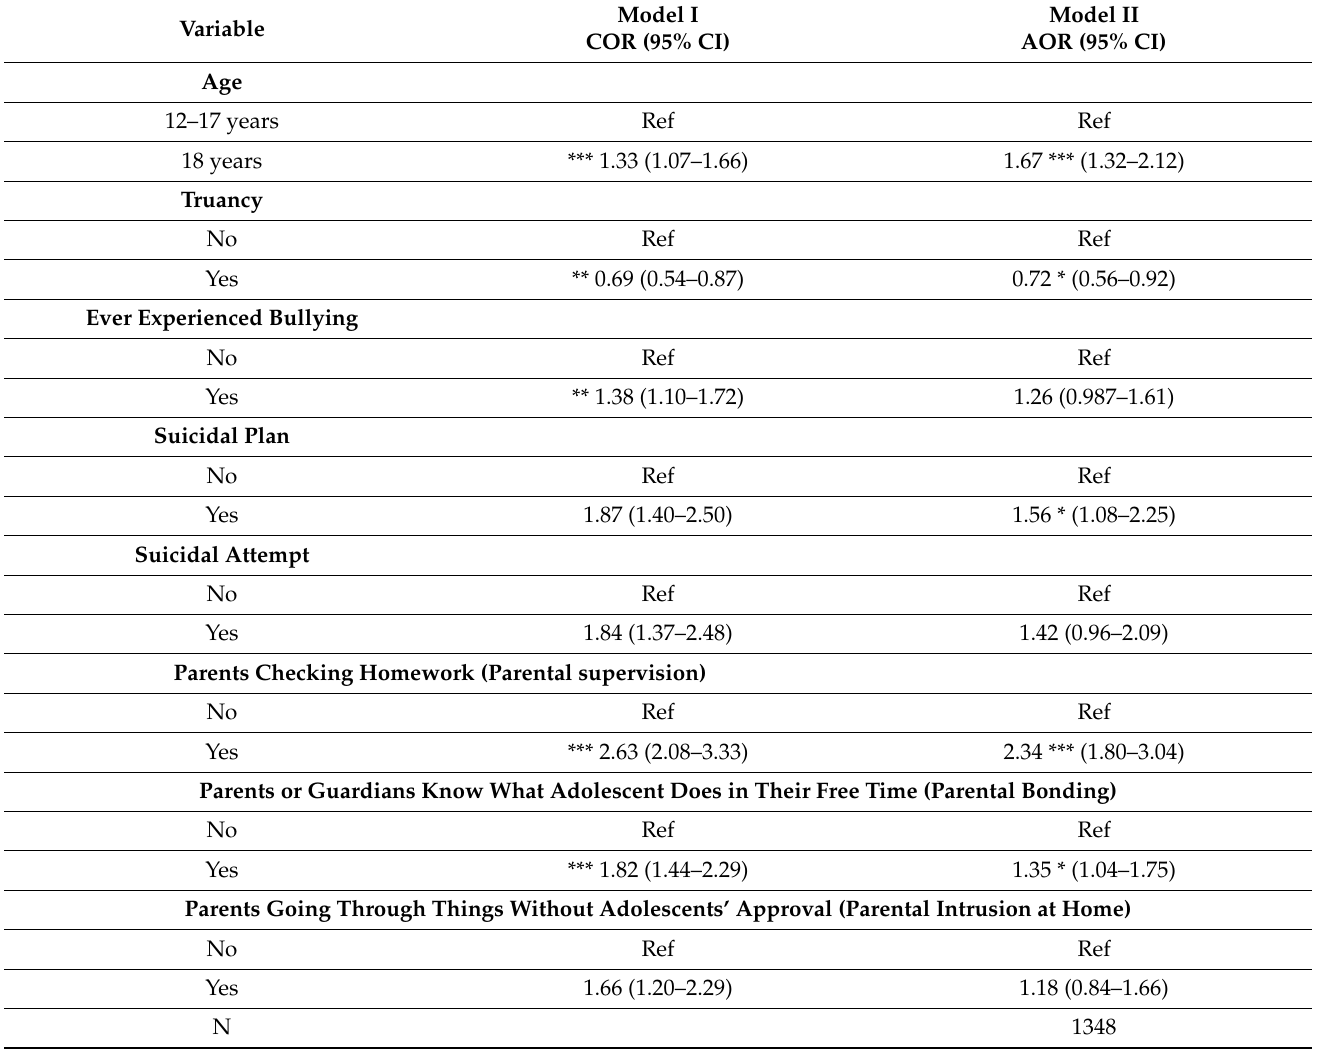
Table 4. Logistic Regression Analysis on the Predictors of Oral Hygiene among Adolescents in